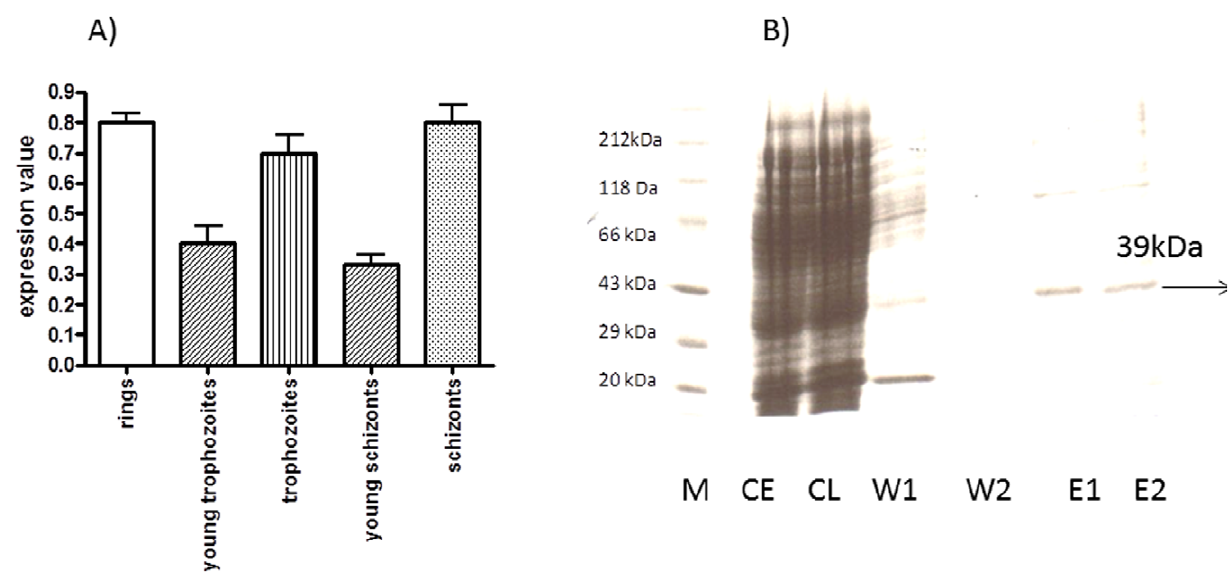
Figure 4. A: Transcriptional profile of P.vivaxdohh throughout the 48 h intraerythrocytic life cycle. Cellular RNA was isolated from a clinical isolate obtained from a patient infected with P. vivax at different developmental stages of the infection during the intraerythrocytic life cycle. Expression values were determined for all given developmental stages (x-axis) in comparison to an average value obtained from a housekeeping gene (y-axis). B: Purification of P. vivax DOHH by Nickel-chelate-affinity chromatography. Lane 1) Standard protein marker from Roth (Karlsruhe, Germany); Lane 2) Bacterial lysate; Lane 3) Crude extract; Lane 4) Wash fraction 1; Lane 5) Wash fraction 2; Lane 6) Eluate fraction 1; Lane 7) Eluate fraction 2. The SDS-PAGE gel was stained by Coumassie